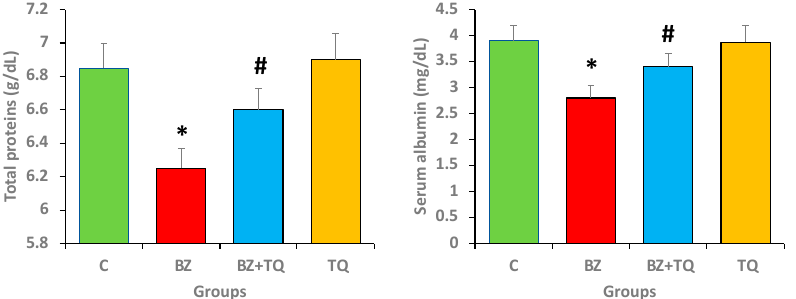
Figure 2. The protein profile (total protein and serum albumin) in different animal groups. The values indicate the mean ± SEM, with 8 animals/group. The statistical differences are denoted with an asterisk (*), indicating significance at p < 0.05 in comparison with the control group, and a hashtag (#), signifying p < 0.05 in comparison with the disease control group.